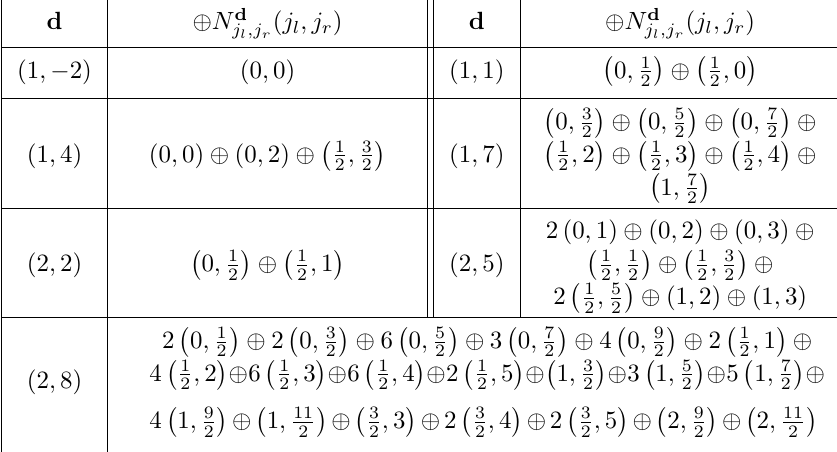
Table 14. BPS spectrum of P 2 + 1 Adj theory with d 1 ≤ 2 and d 2 ≤ 9 . Here, d = ( d 1 , d 2 ) labels the BPS states with charge d 1 ˜ m + d 2 ˜ φ